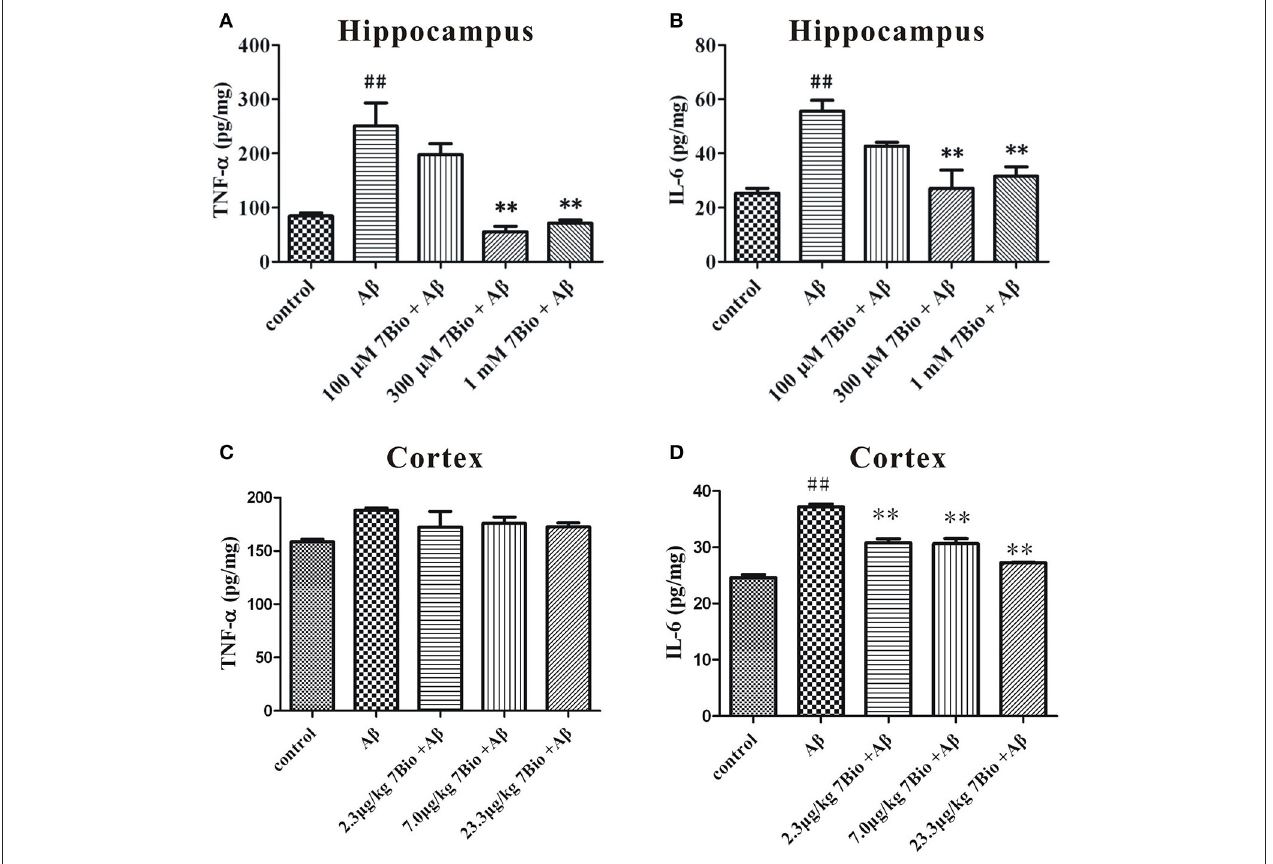
FIGURE 7 | 7Bio attenuates A β oligomer-induced increase of TNF- α and IL-6 in mice. At day 19 post-surgery, mice were sacrificed. The levels of TNF- α (A for hippocampus and C for cortex) and IL-6 (B for hippocampus and D for cortex) were evaluated by ELISA assay in the hippocampal and cortical extraction of mice, respectively. Data represent the mean ± SD ( n = 3); ## p < 0.01 vs. control group, ** p < 0.01 vs. A β group (one-way ANOVA and Tukey’s